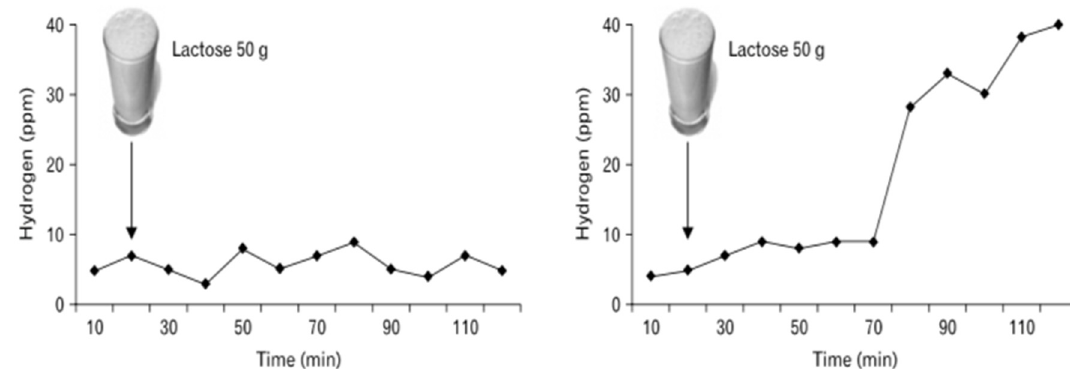
Figure 4. Example results from lactose malabsorption and intolerance—hydrogen breath test (HBT) with a 50 g oral lactose load. Left depicts a negative result; right depicts a positive result (as taken from [29]).